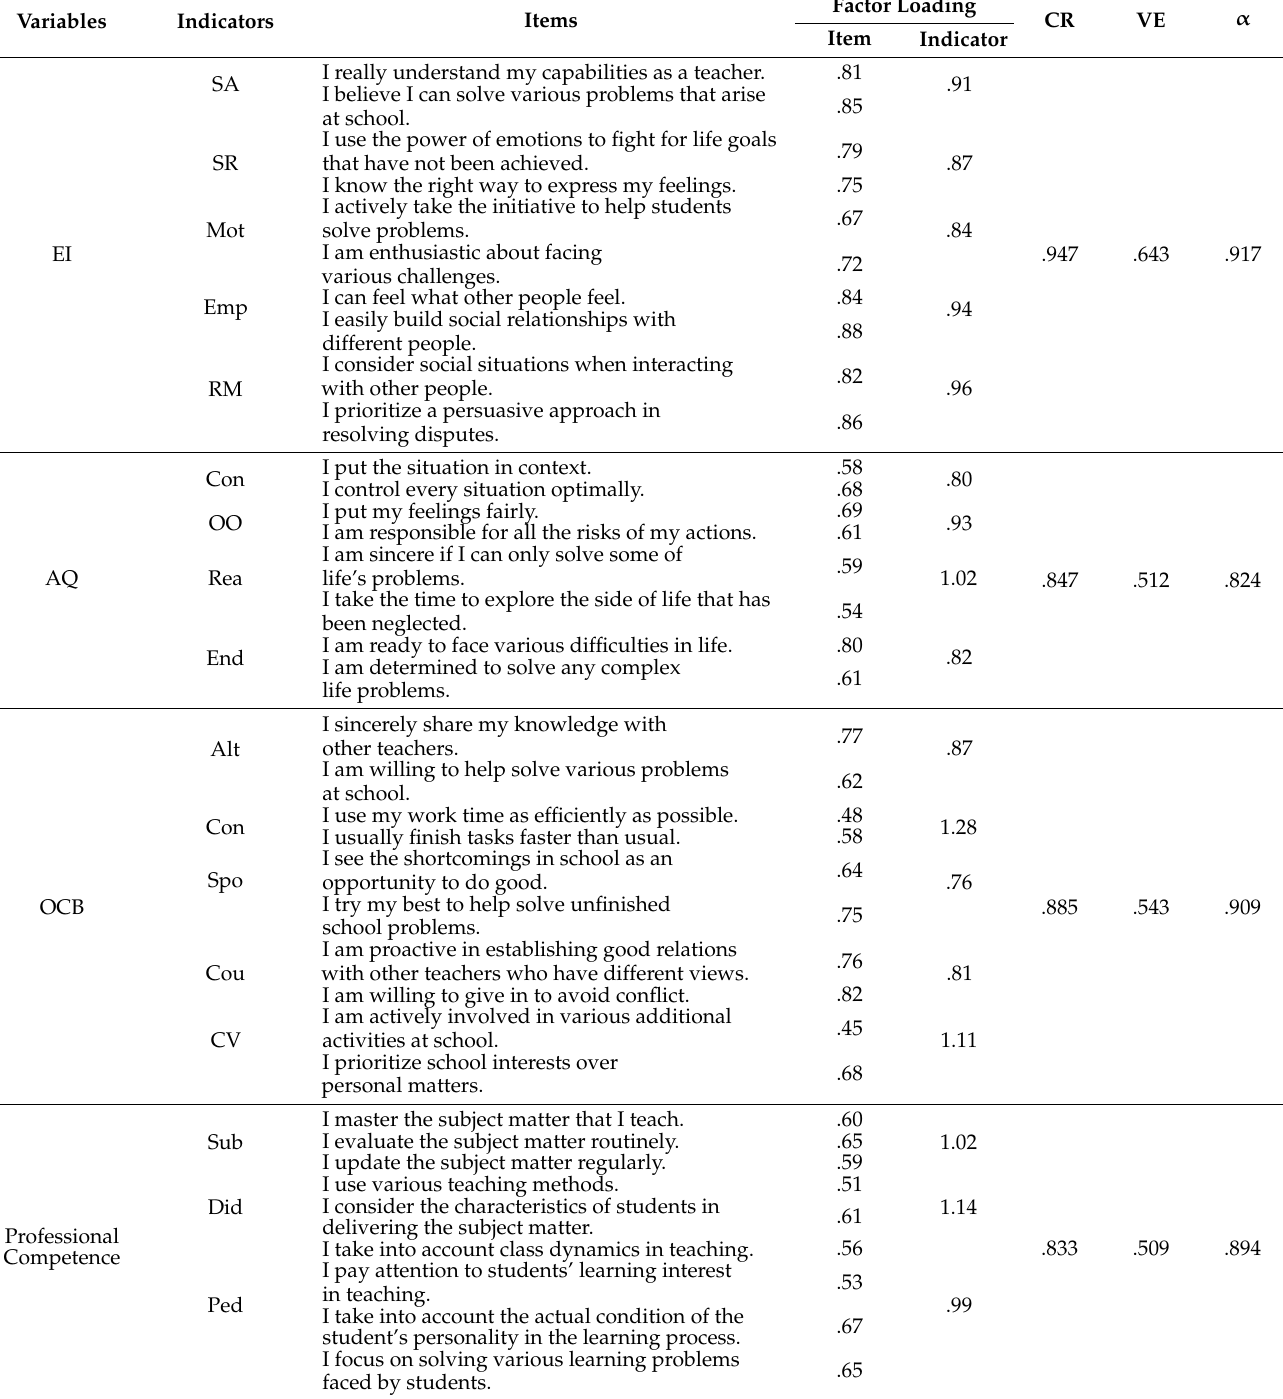
Table 3. The measurement model